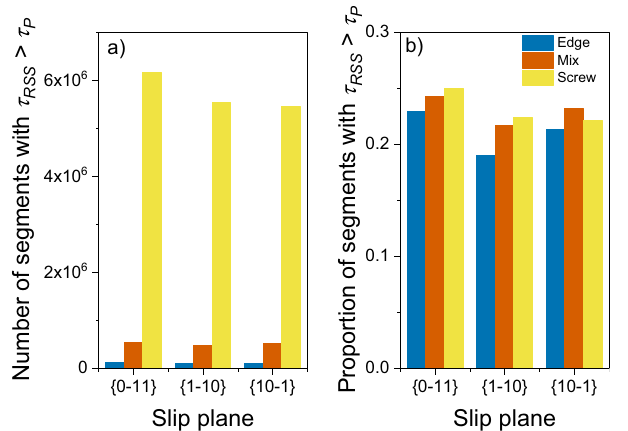
Fig. 6 Distribution of segments with stresses exceeding the Peierls stress. a Number of segments subjected to stresses that exceed τ P . The dominance of screw dislocations in the stress landscape above τ P agrees with the proportions seen in Fig. 5. b Proportion of segments above τ each dislocation behavior type. This shows that the fundamental difference in dislocation behavior stems more from the availability of segments of a particular orientation than a fundamental difference in their